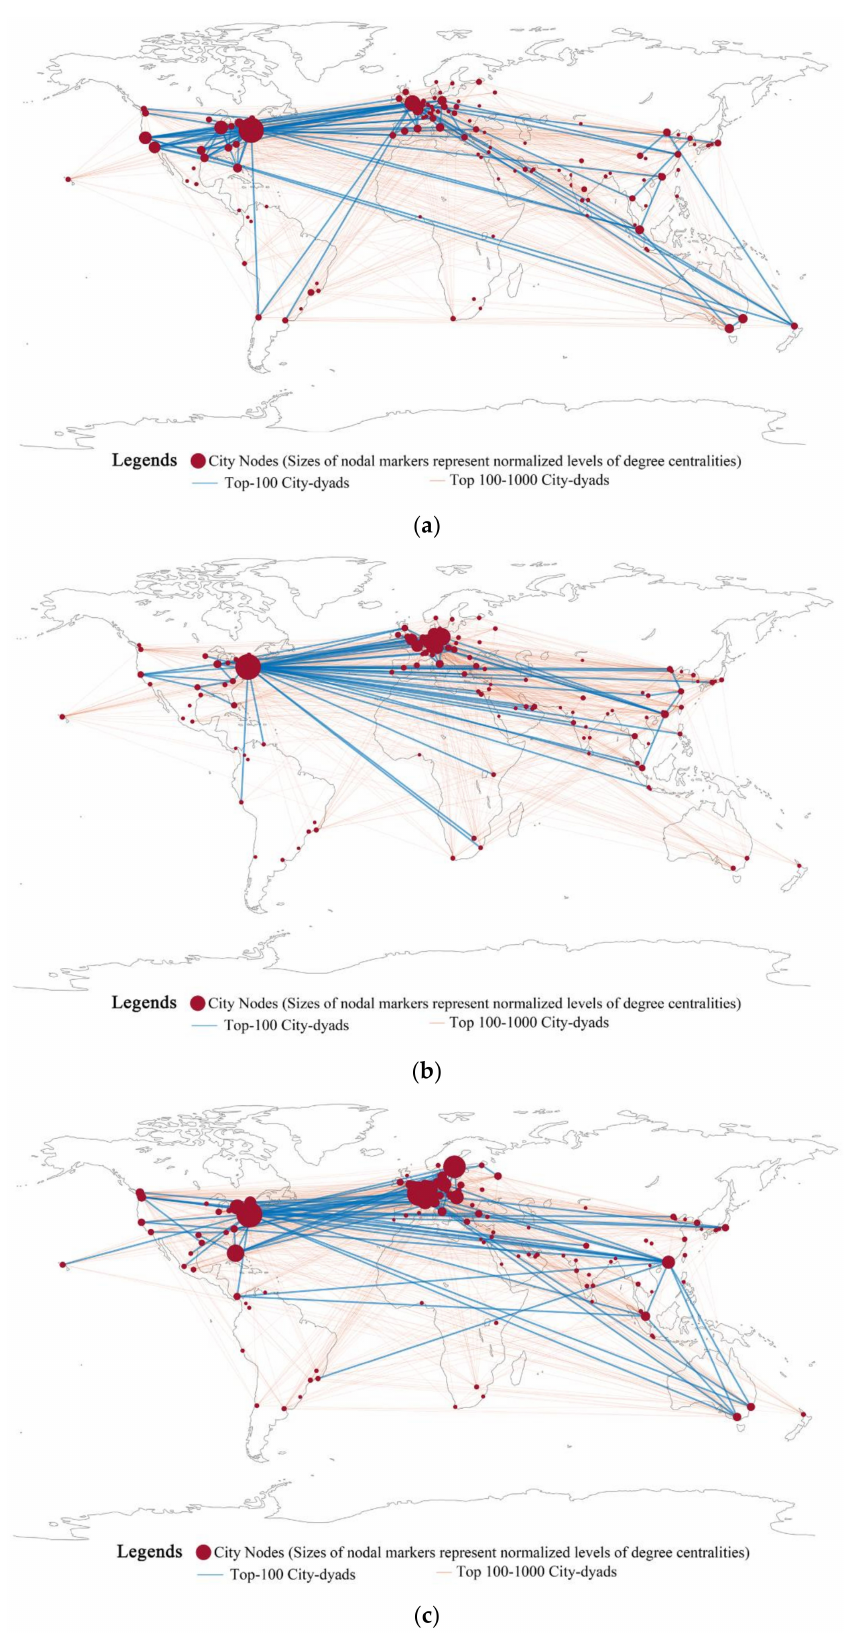
Figure 1. Geographic distributions of world city nodes and dyads in three languages: ( a ) English, ( b ) German, ( c )